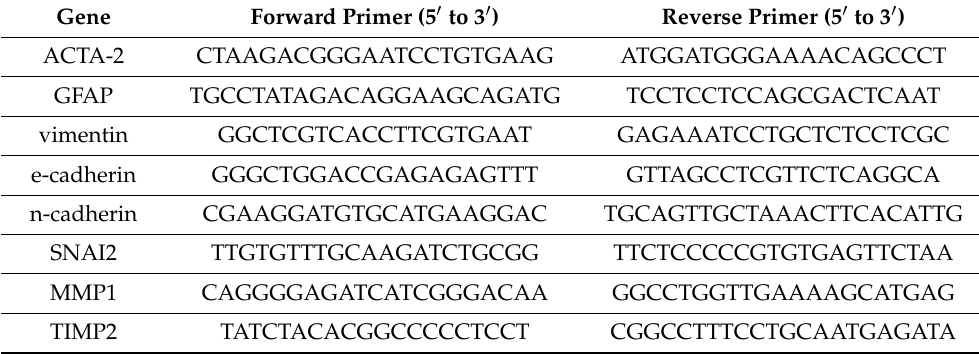
Table A1. List of primers used for quantitative real-time